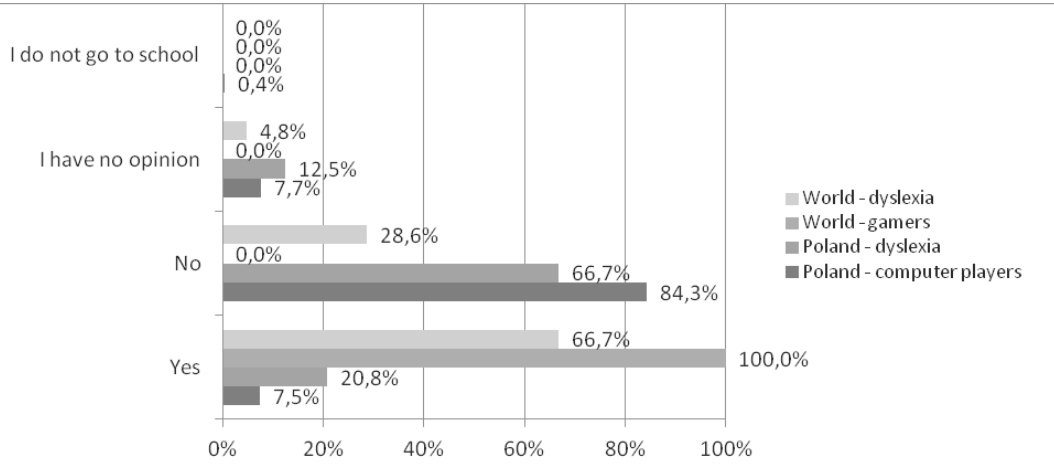
Figure 3. (cid:53)(cid:72)(cid:77)(cid:72)(cid:70)(cid:87)(cid:76)(cid:82)(cid:81)(cid:3)(cid:69)(cid:92)(cid:3)(cid:83)(cid:72)(cid:72)(cid:85)(cid:86)